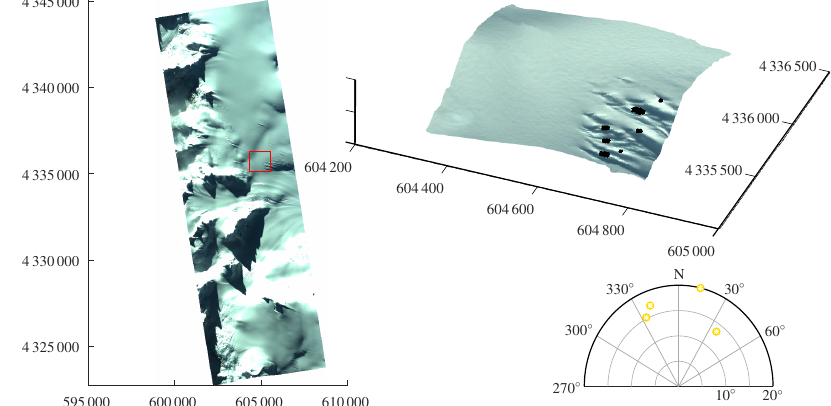
Figure 3. Left ) A planetScope acquisition over the upper part of Tyndall-Glacier. Upper right ) The estimate surface model is derived from the section outlined in red, on the left panel. The planar axis in this panel is in meters (UTM), while the vertical axis is a relative scale. Lower right ) Polar plot of the sun angles of the imagery used for the